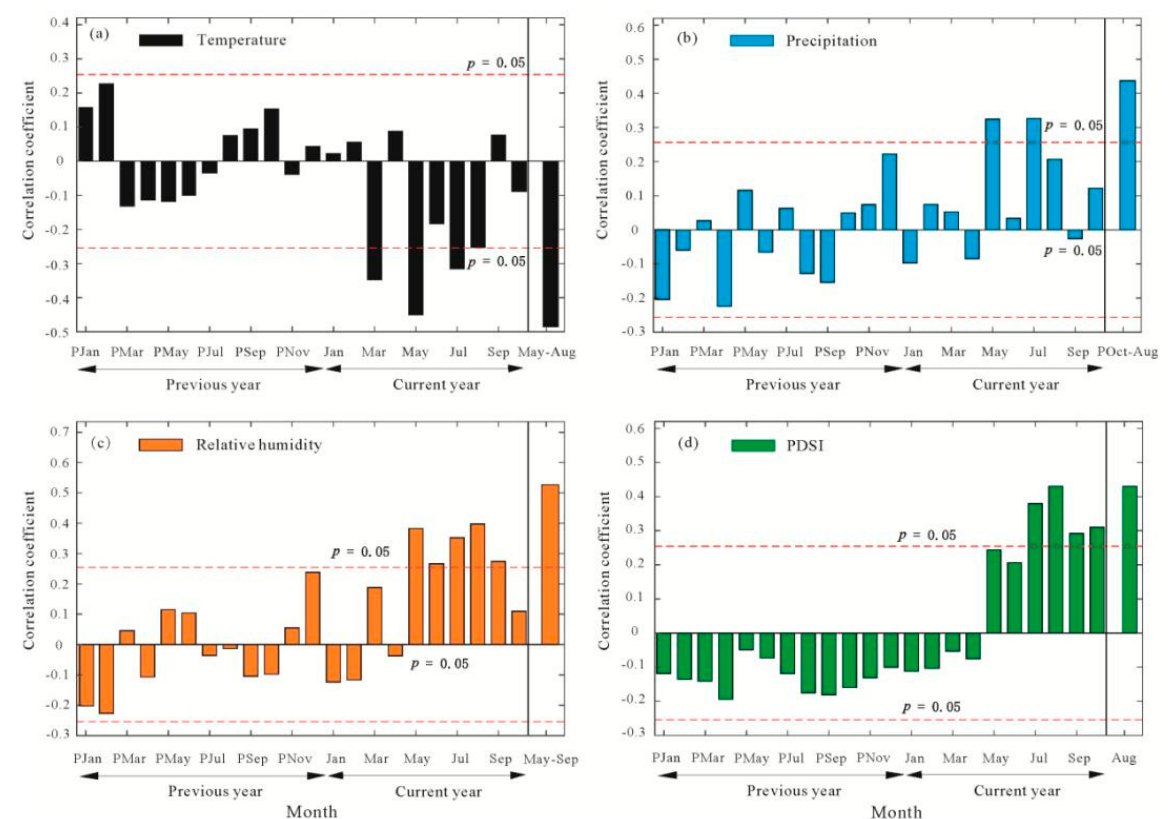
Figure 5. Correlation analysis between tree-ring cellulose ∆ 13 C series of P. tabulaeformis and temperature (a), precipitation (b), relative humidity (c), PDSI (d) in Mt. Shimen during 1952–2011.